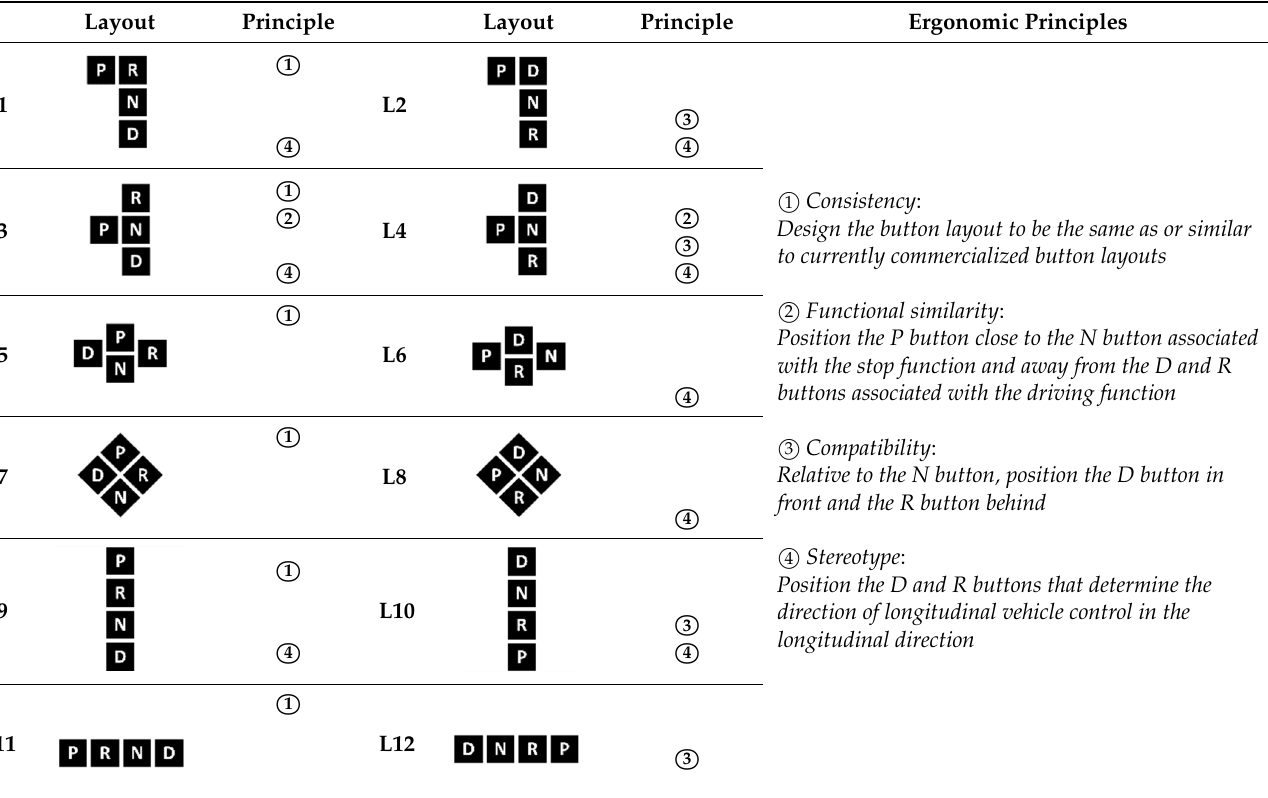
ergonomic layout design principles applied in each design alternative are also indicated. Table 3. Twelve design alternatives and corresponding ergonomic principles. Table 3. Twelve design alternatives and corresponding ergonomic principles. Table 3. Twelve design alternatives and corresponding ergonomic principles. Table 3. Twelve design alternatives and corresponding ergonomic principles. Table 3. Twelve design alternatives and corresponding ergonomic principles. Table 3. Twelve design alternatives and corresponding ergonomic principles. Table 3. Twelve design alternatives and corresponding ergonomic principles. Table 3. Twelve design alternatives and corresponding ergonomic principles. Table 3. Twelve design alternatives and corresponding ergonomic principles. Table 3. Twelve design alternatives and corresponding ergonomic principles. Table 3. Twelve design alternatives and corresponding ergonomic principles. Table 3. Twelve design alternatives and corresponding ergonomic principles. Table 3. Twelve design alternatives and corresponding ergonomic principles.